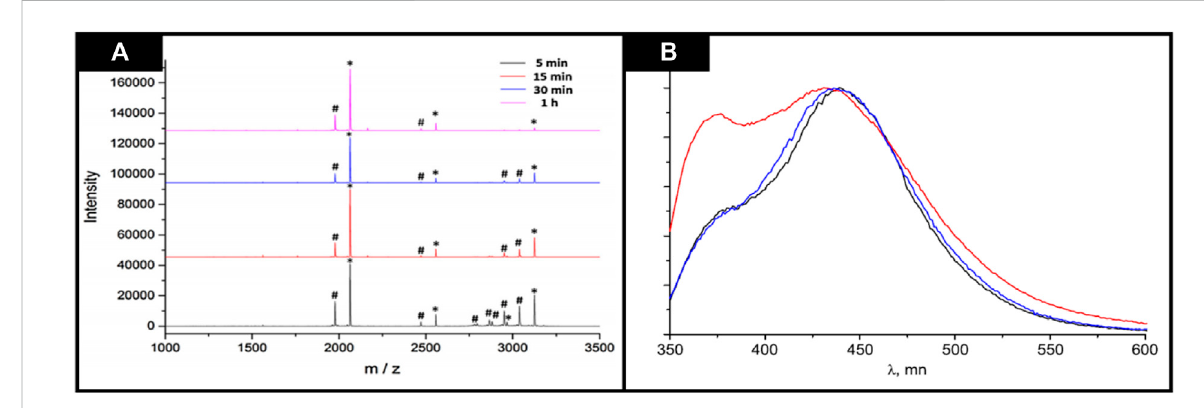
FIGURE 12 (A) Incubation time optimization for phosphopeptides enrichment in2 × 10 – 7 M – casein by using Fe 3 O 4 @ZnBLD composites ( “ * ” shows phosphopeptides and “ # ” shows dephosphorylated peptides after HPO 3 loss). Reproduced with permission from (Gu et al., 2016) (B)